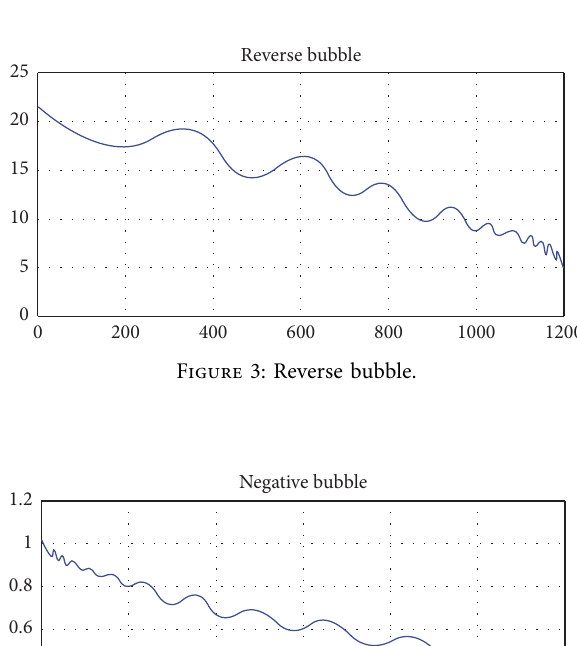
Figure 2: Bubble.